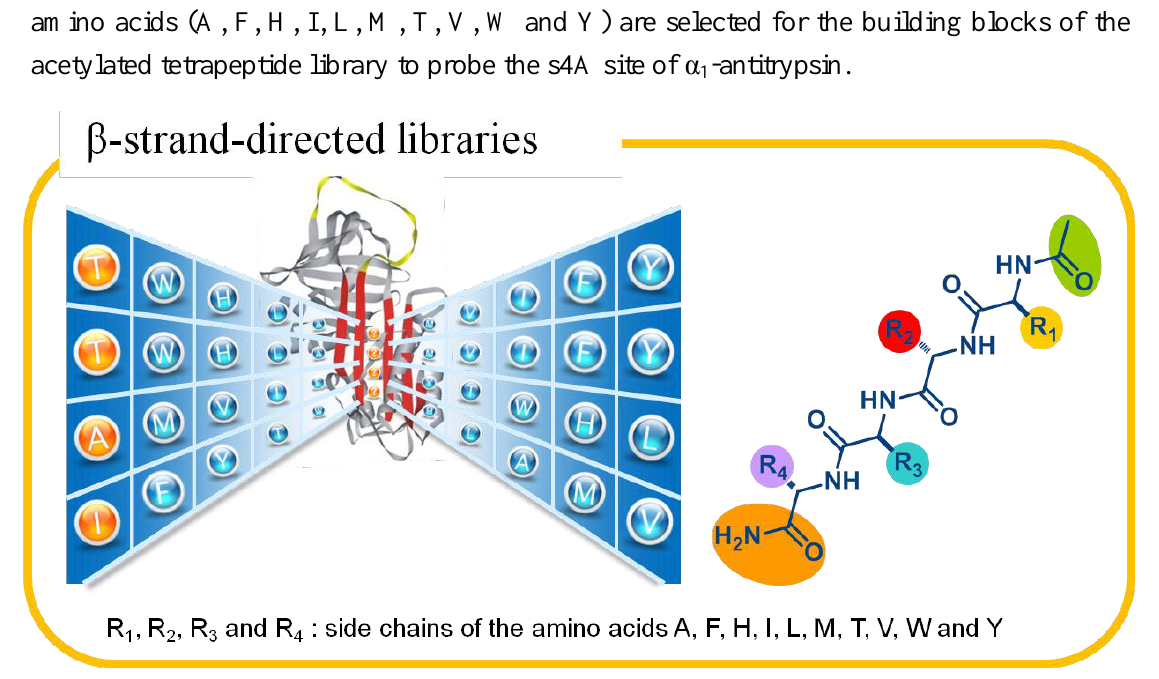
Figure 6. Targeting the s4A site with β-strand-directed libraries. The 10 β-sheet preferred amino acids (A, F, H, I, L, M, T, V, W and Y) are selected for the building blocks of